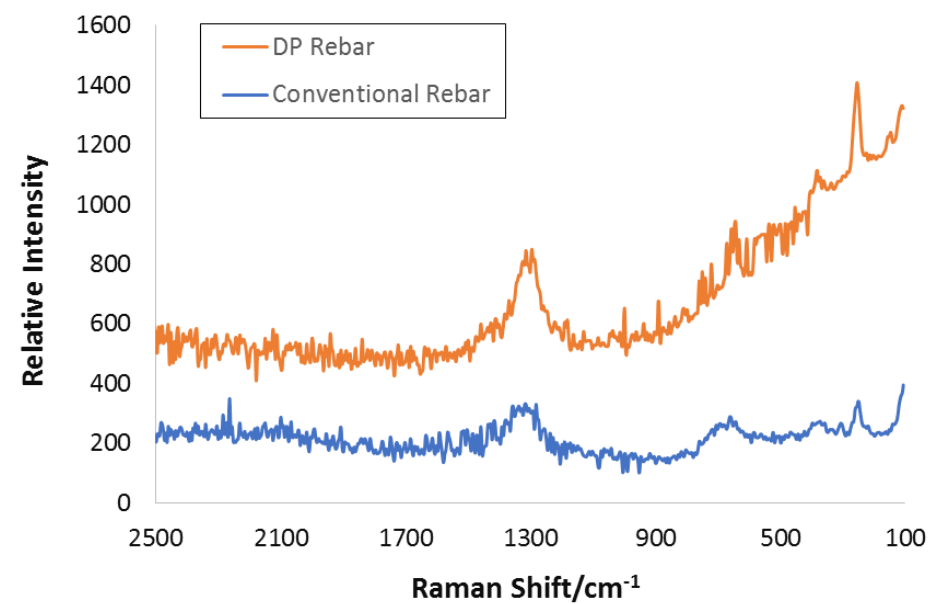
Figure 12. Raman spectroscopy images in alkaline and Cl − solutions after potentiodynamic polarization.